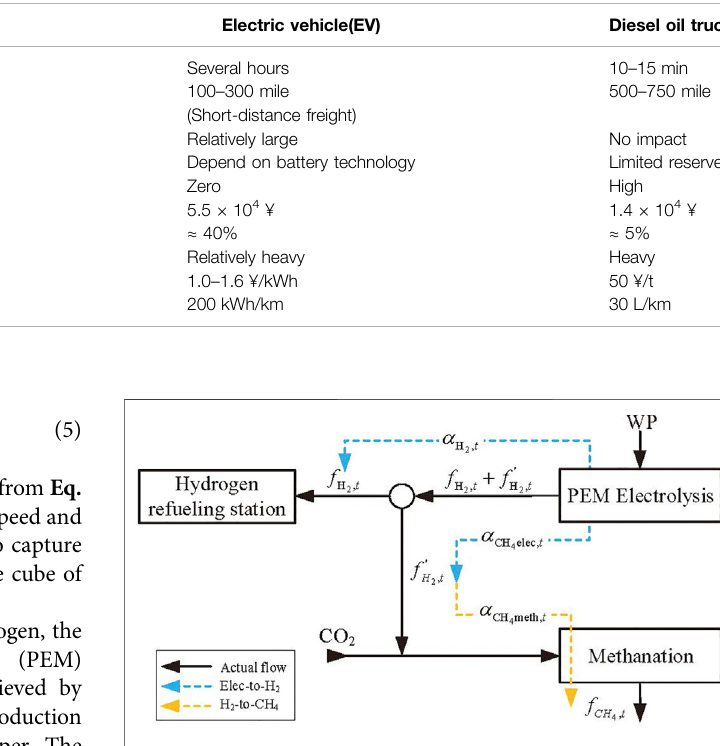
FIGURE 2 | Schematic diagram of actual fl ow and variable symbols of P2G